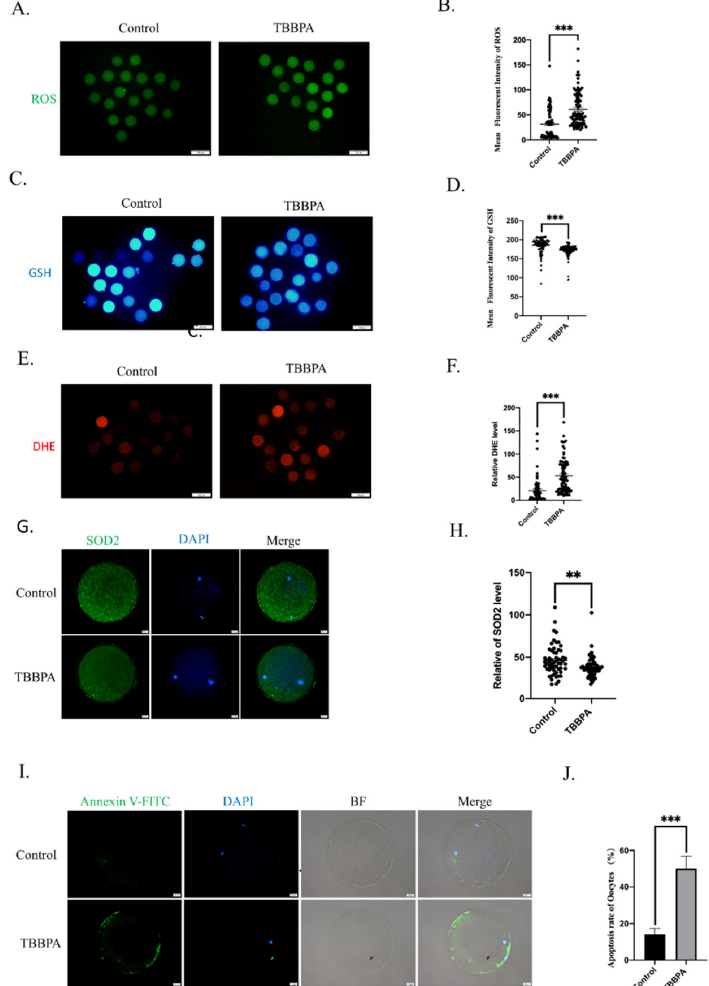
Figure 3. Effects of TBBPA on oxidative stress and apoptosis in oocytes: ( A ) Generation of ROS after TBBPA treatment. Ex/Em, 488/530 nm. Scale bar = 100 μ m. ( B ) ROS levels were reflected by the mean